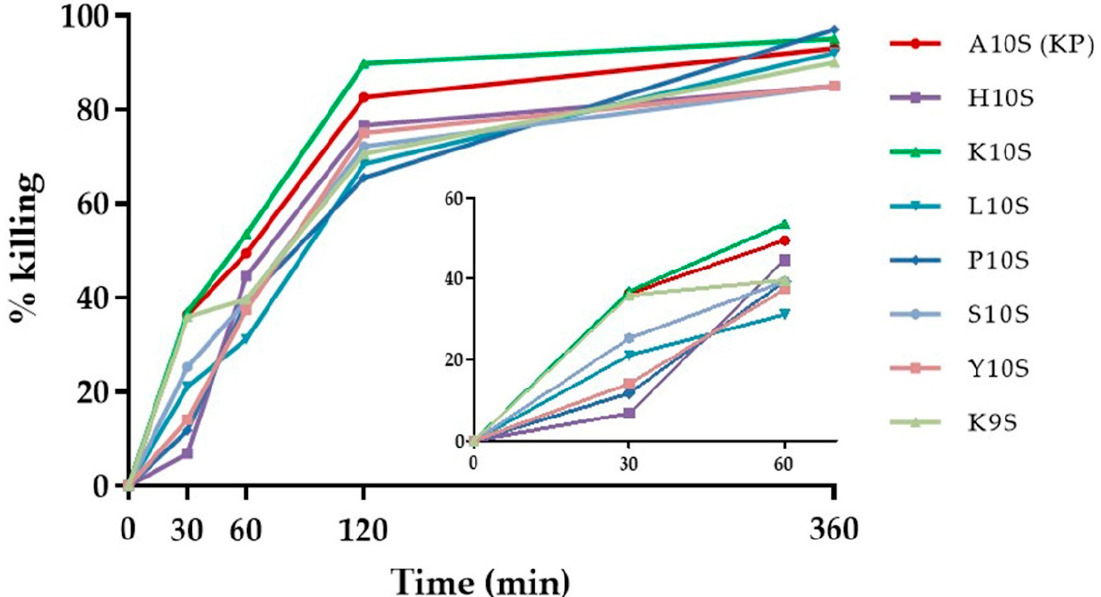
Figure 1. Time kinetics of C. albicans SC5314 killing. Peptides were used at their 2 × EC 50 value. The activity is expressed as percentage killing, calculated as: 100-(average number of CFUs in the peptide-treated group/average number of CFUs in the control group) ×